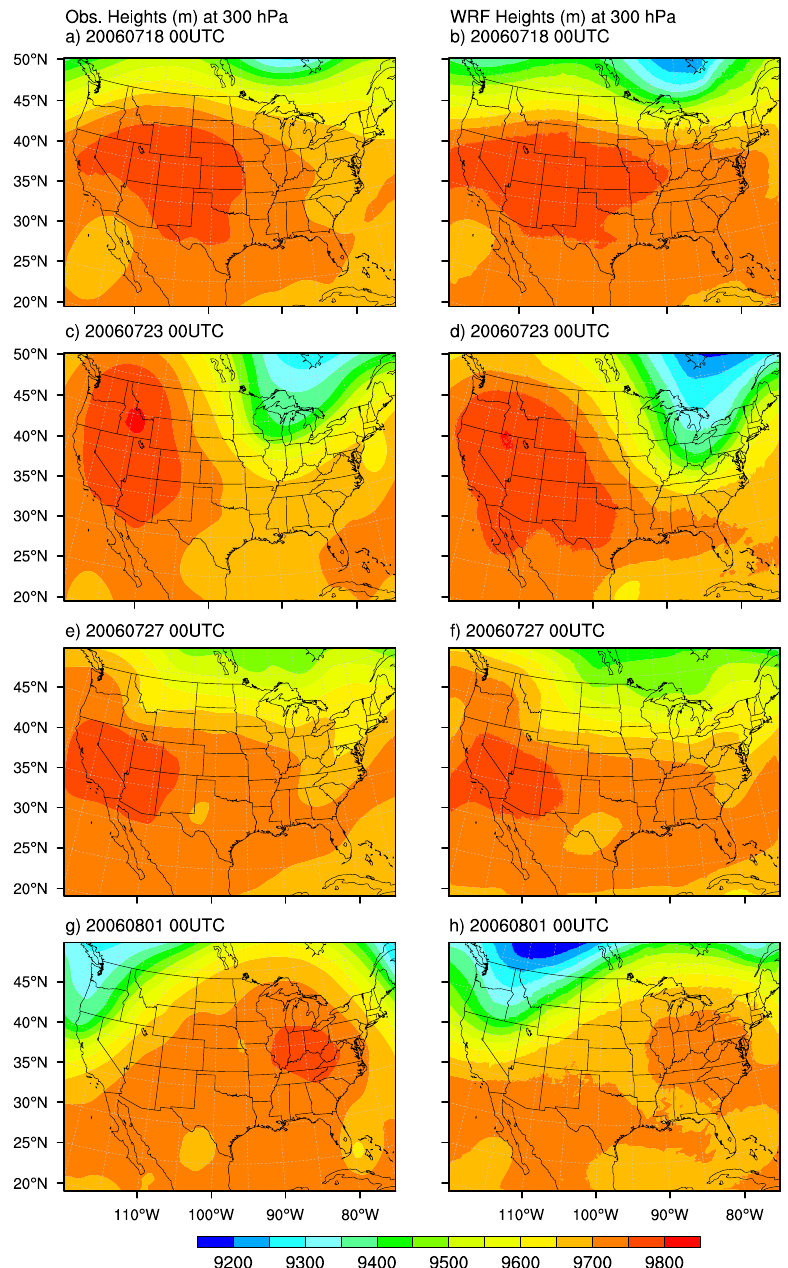
Fig. 2. Spatial distribution of 300hPa geopotential heights (m) from the ECMWF ERA-Interim reanalysis (left panels) and WRF-Chem model results (right panels) at 00:00UTC for 18 July 2006 (a, b) , 23 July 2006 (c, d) , 27 July 2006 (e, f) , and 01 August 2006 (g, h)